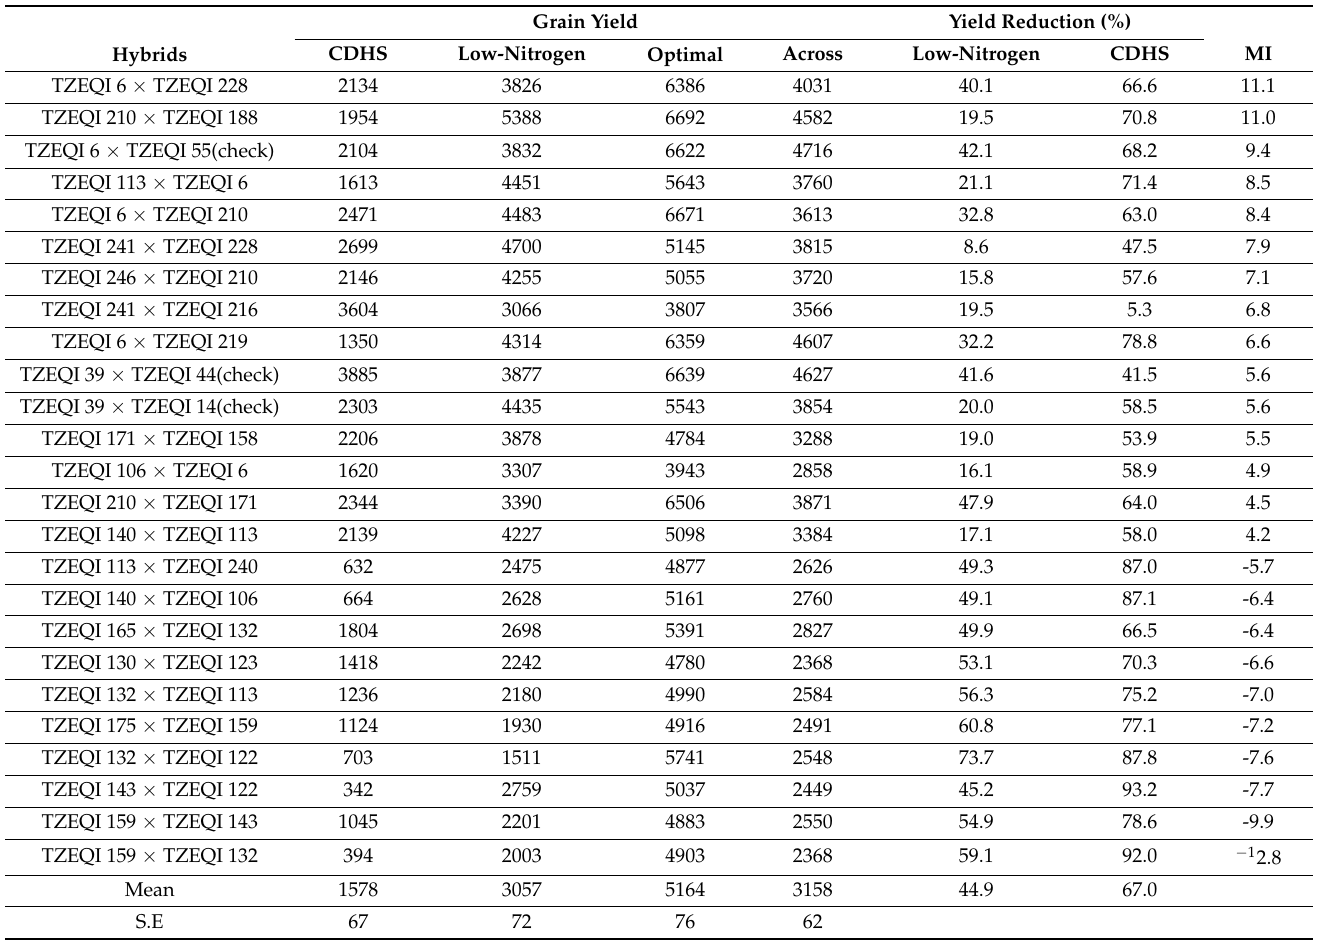
Table 5. Grain yield performance of selected QPM hybrids across the stress environments. Grain